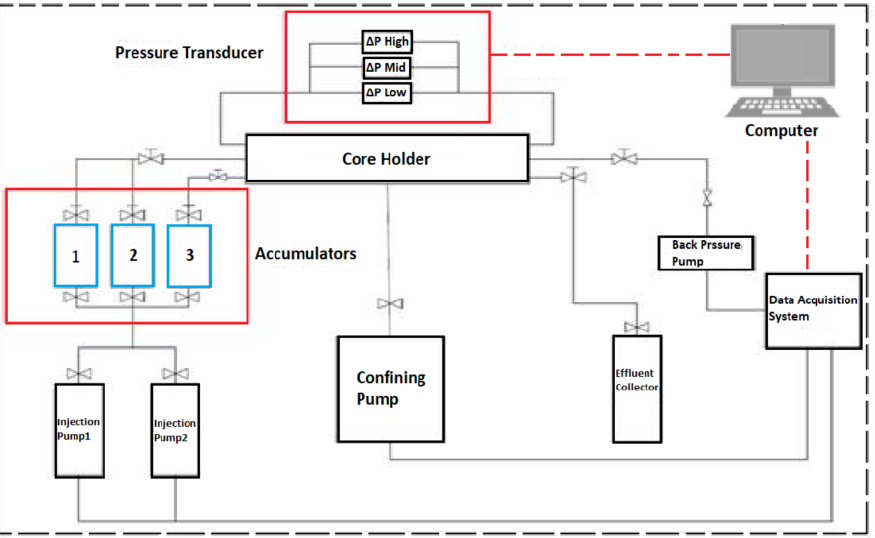
Figure 9. The Core-flooding System Unit (i.e., CFS-830-Z, King Abdulaziz City for Science and Technology, KACST, Saudi Arabia).